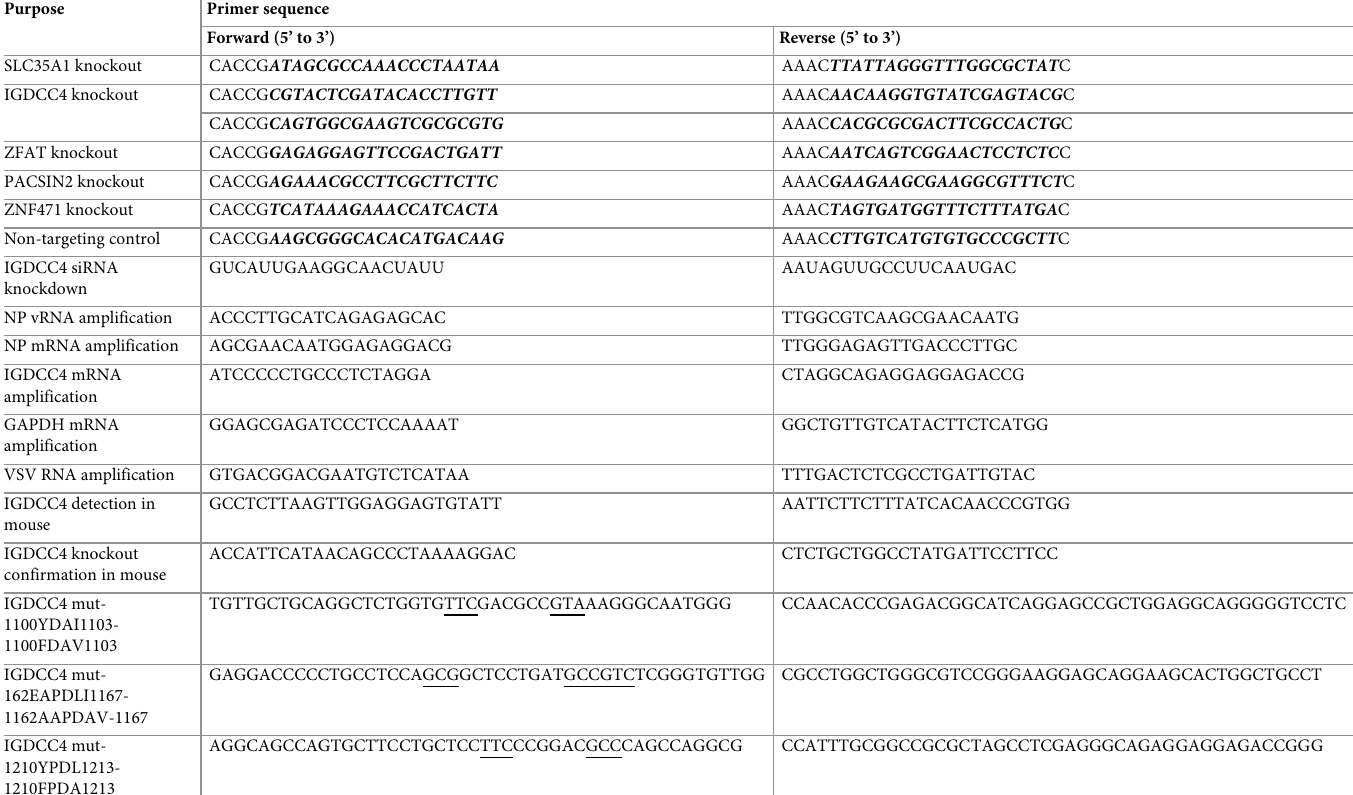
Table 1. Sequence information of primers used in this study a